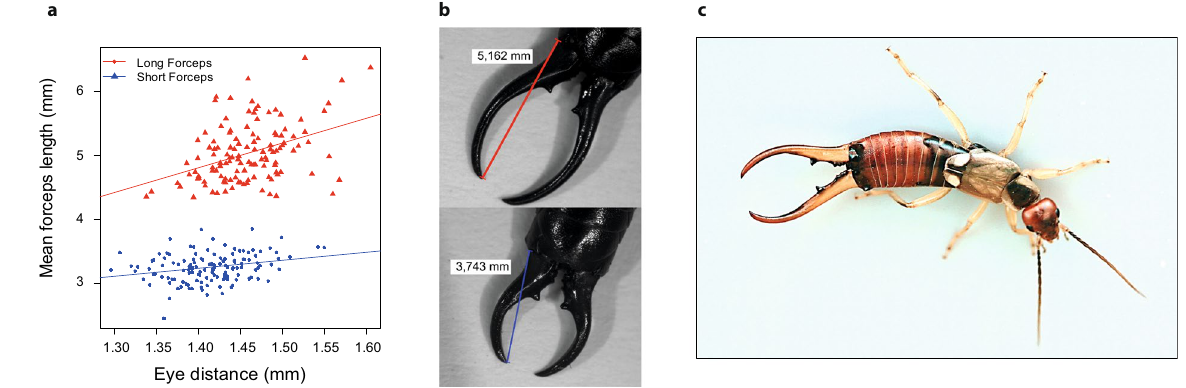
Figure 1. ( a ) Different association between eye distance (proxy for body size) and forceps length for long forceps males (P > 0.001) and short forceps males (P = 0.041). The difference in correlation was accounted for when calculating the relative forceps length used in the analyses. ( b ) Illustrative examples of measured long and short forceps. ( c ) Male specimen of Forficula auricularia with long forceps (Photo: Joël